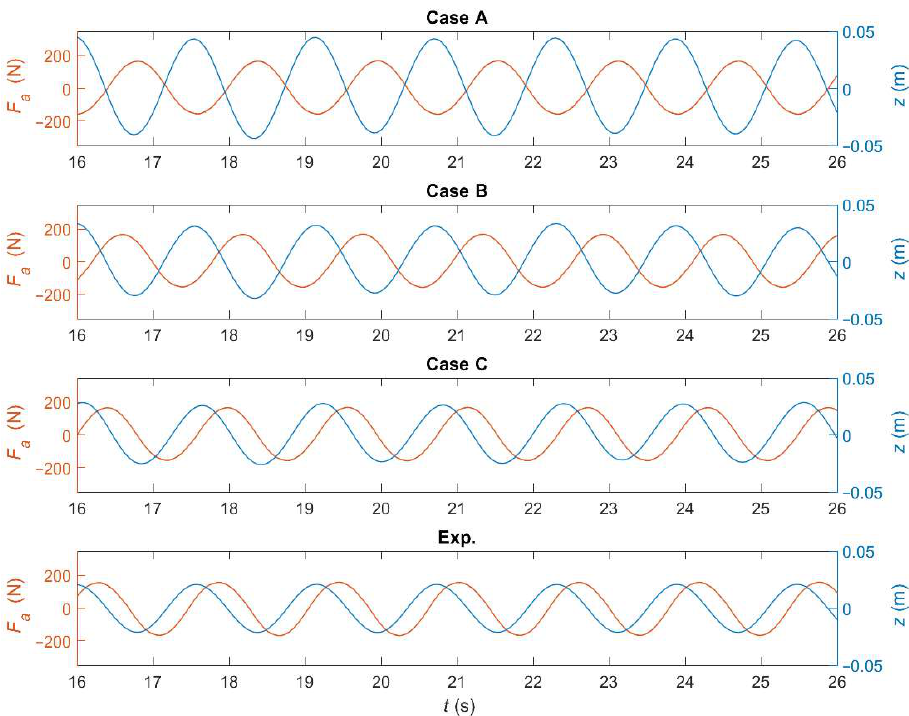
Figure 14. Numerical and experimental time series of the actuator force (left axis) and heave position (right axis) for three different phases (π, 3π/4, and π/2 rad) with an open-loop system.